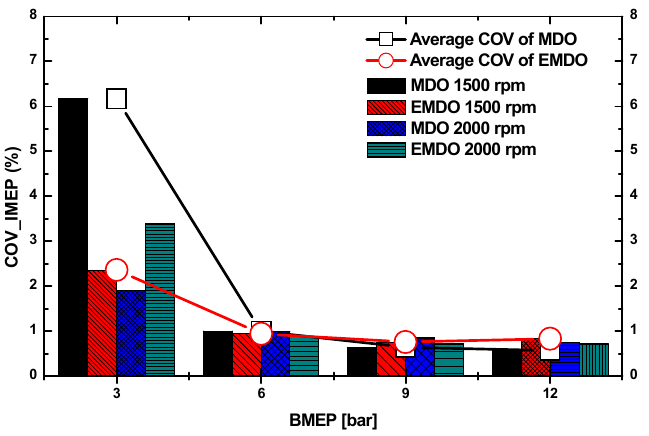
Figure 14. Combustion stability characteristics according to rpm and brake mean effective pressure (BMEP).